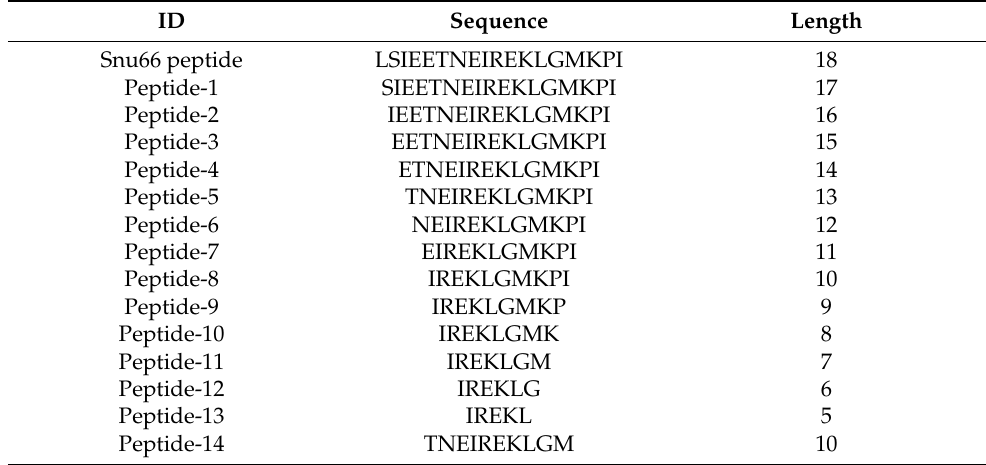
Table 2. Overview table showing the peptides docked in the Hub1 protein including their primary sequence and the residue length.